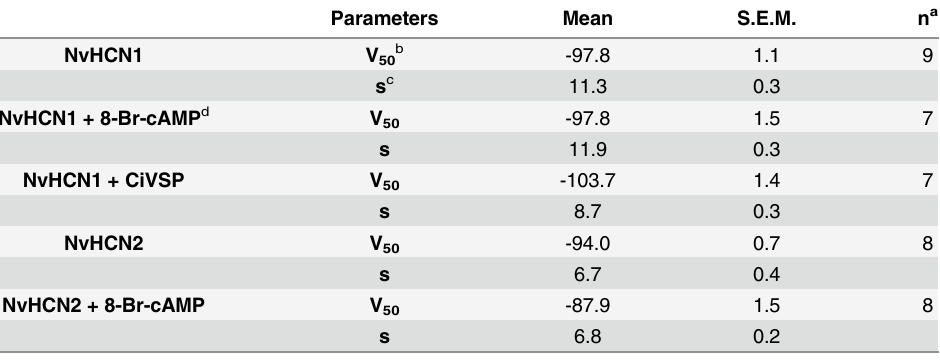
Table 1. Boltzmann fit parameters for NvHCN1 and NvHCN2 GV curves. Parameters